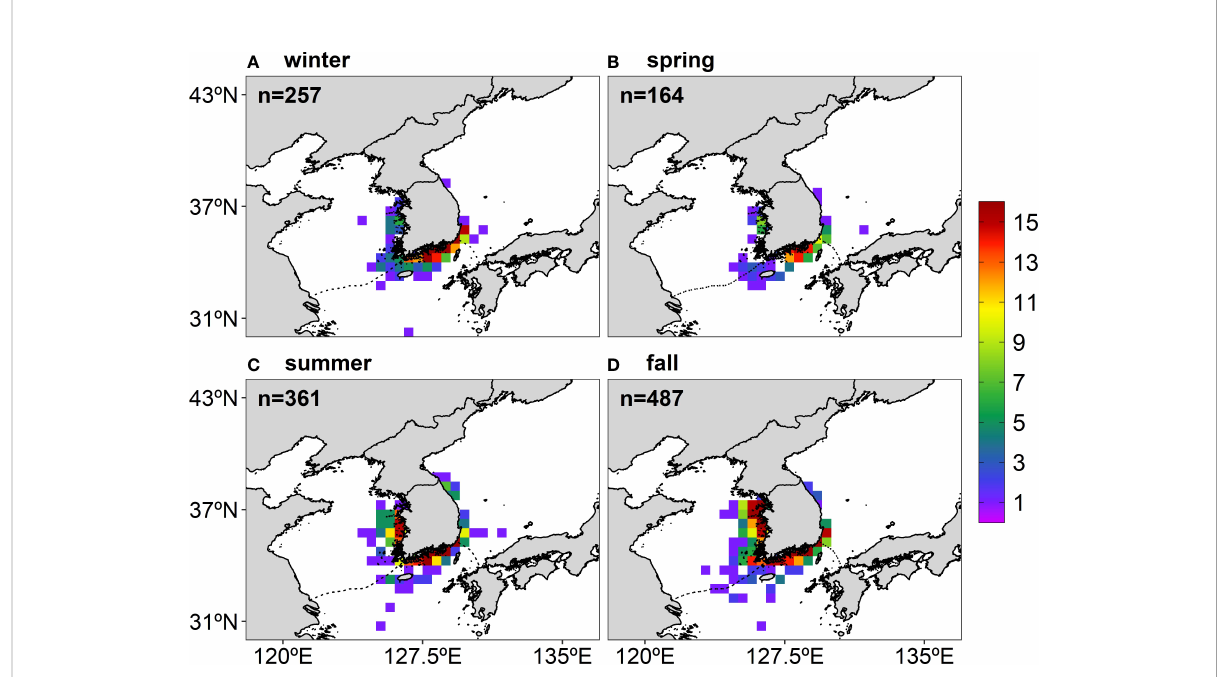
FIGURE 2 The number of the anchovy presence points for each season during the study period (16 years, 2000 – 2015) from the catch data archived by the National Federation of Fisheries Cooperatives in Korea: (A) winter, (B) spring, (C) summer, and (D) fall. The total number of presence points used for the MaxEnt construction is marked on the upper left side of each fi